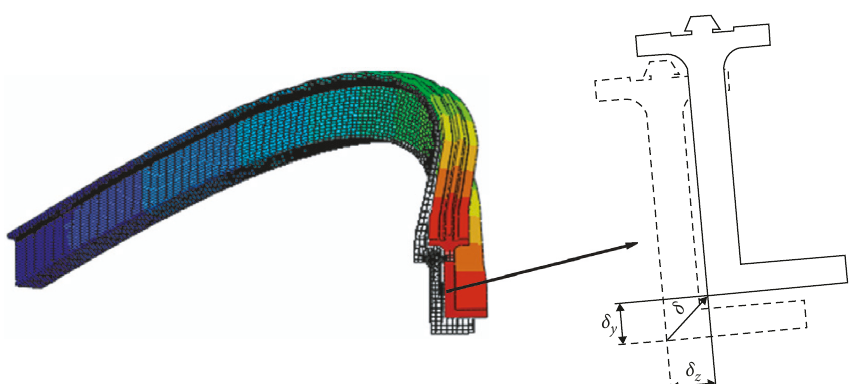
Figure 3: The front and back spatial positions of the end face